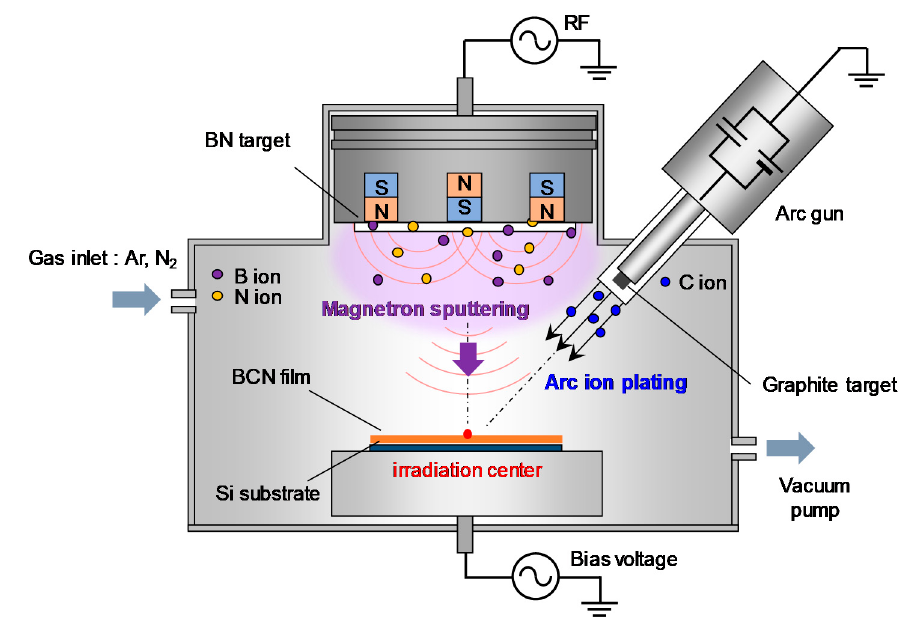
Figure 1. Schematic of the arc-sputtering hybrid coating setup. Table 1. Deposition conditions for amorphous carbon (a-C) film and amorphous boron carbon nitride (a-BCN) films.